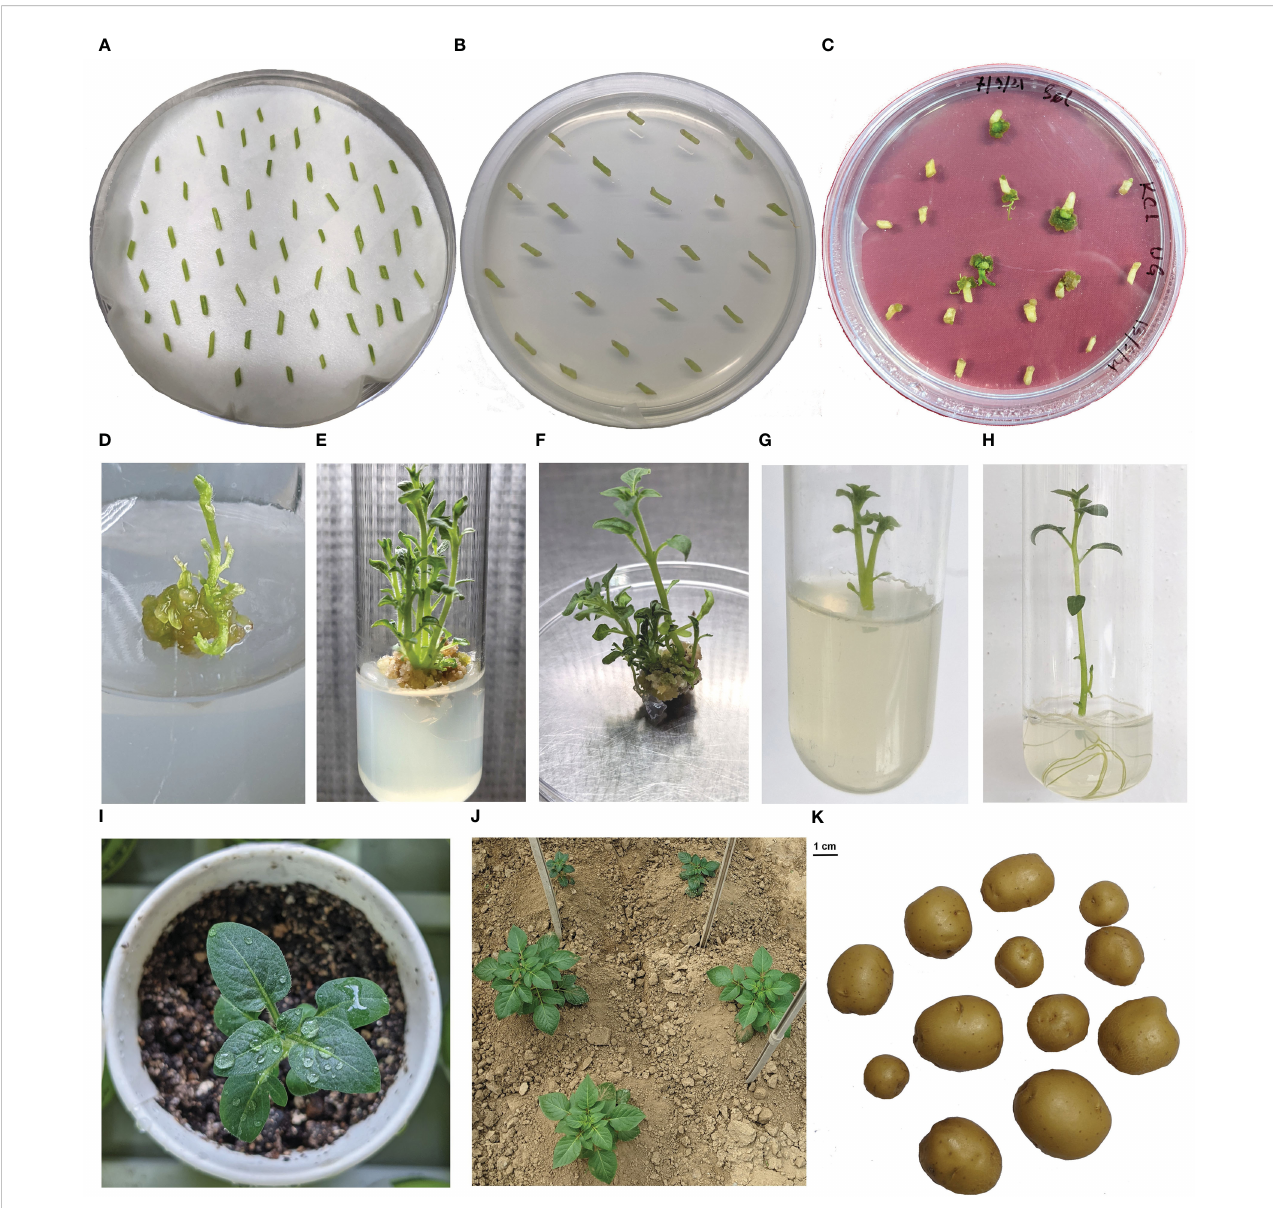
FIGURE 2 Transformation, regeneration, and net house trial of UGPase RNAi potato transgenic lines of KC4. (A) pre-culture, (B) selection, (C) regeneration, (D-F) . shoot elongation, (G) transfer into rooting media, (H) rooting, (I) hardening, (J) net house grown plants, (K) harvested